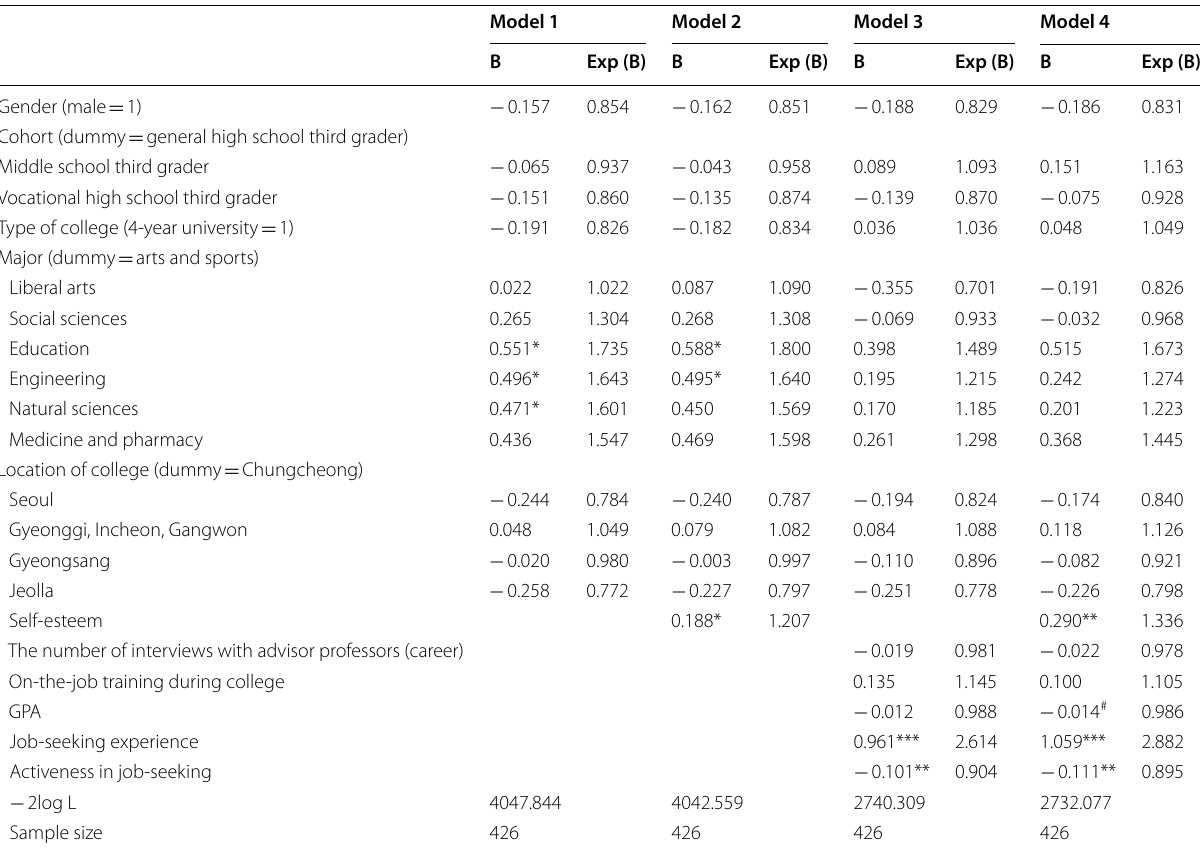
Table 7 Analysis of the determinants of college graduates’ escape from